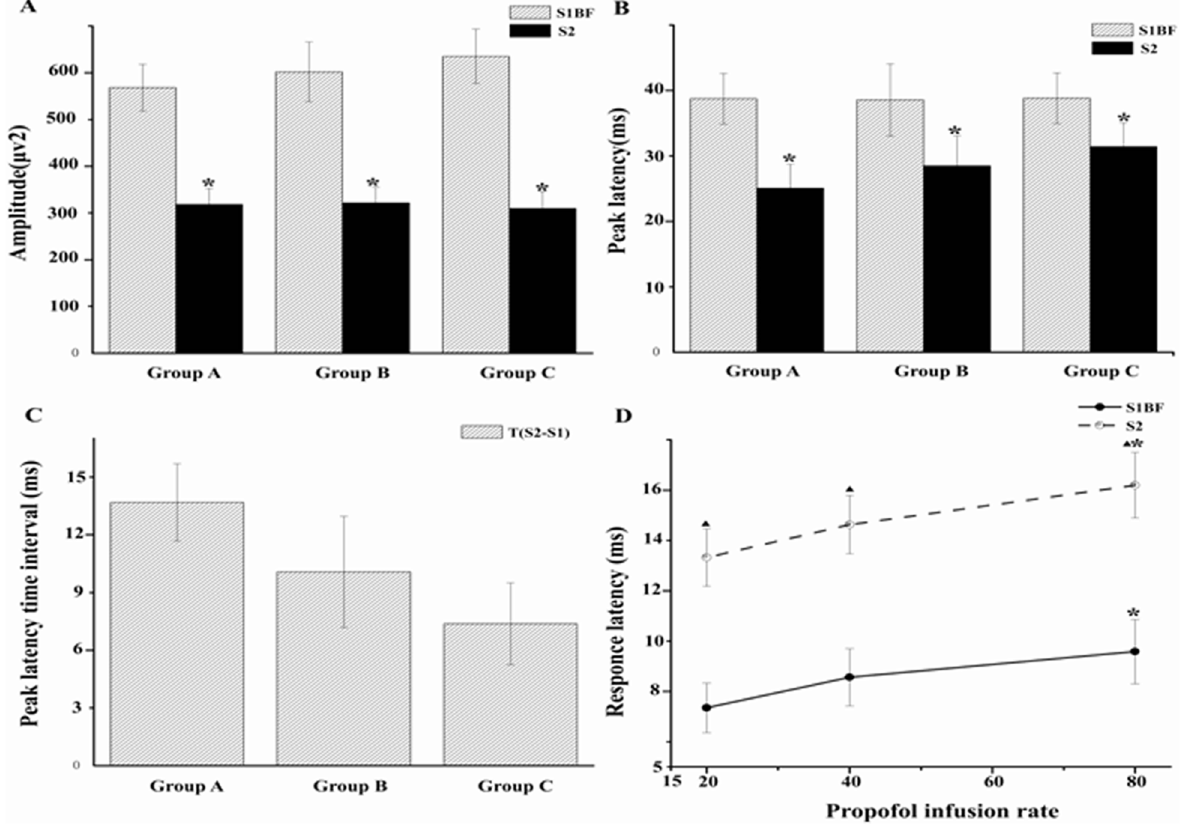
Figure 4. The ERP amplitude and latency (peak and response latency) in S1BF and S2. Panel. A) The left, upper graph shows the change of amplitude by whisker stimulation. The amplitude of S1BF was larger than that in S2 in group A, B and C. B) The right, upper graph shows the change of peak latency by whisker stimulation. The peak latency of S1BF was longer than that in S2 in group A, B and C. C) The left, lower graph shows the time interval of peak latency between S1BF and S2 and there was no difference among the three groups. D) The right lower graph shows the response latency in S1BF and S2. The response latency of S1BF was shorter than that in S2 in three different rates. Compared with group A(20 mg/kg/h), the response latency in group C(80 mg/kg/h) was longer in both S1BF and S2. It gradually decreased to the basic level m p , 0.05, *p , 0.05, level of significance.